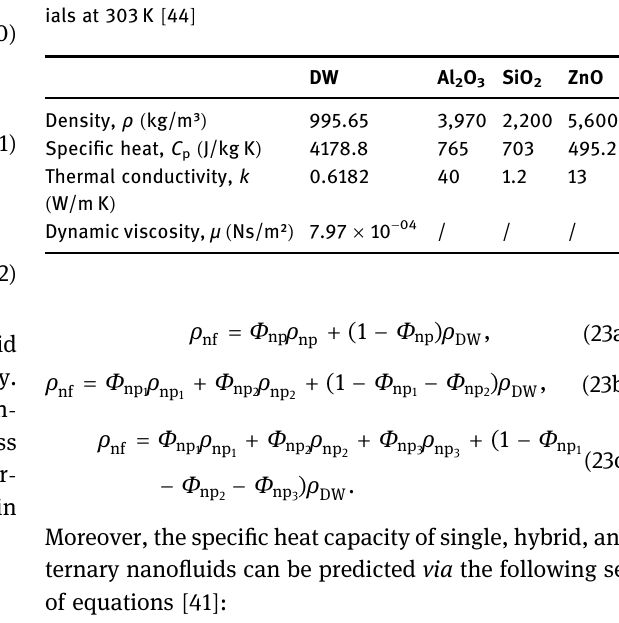
Table 2: Thermophysical properties of base fl uids and nanomater